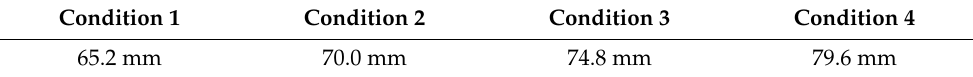
Table 1. Numerical test conditions.